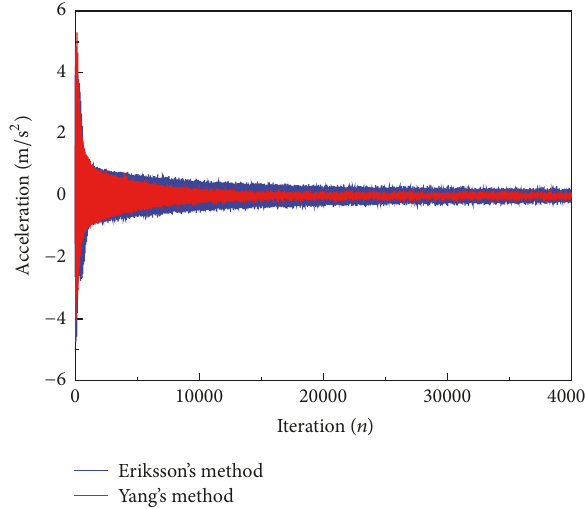
Figure 6: Acceleration of the controlled point of existing methods.